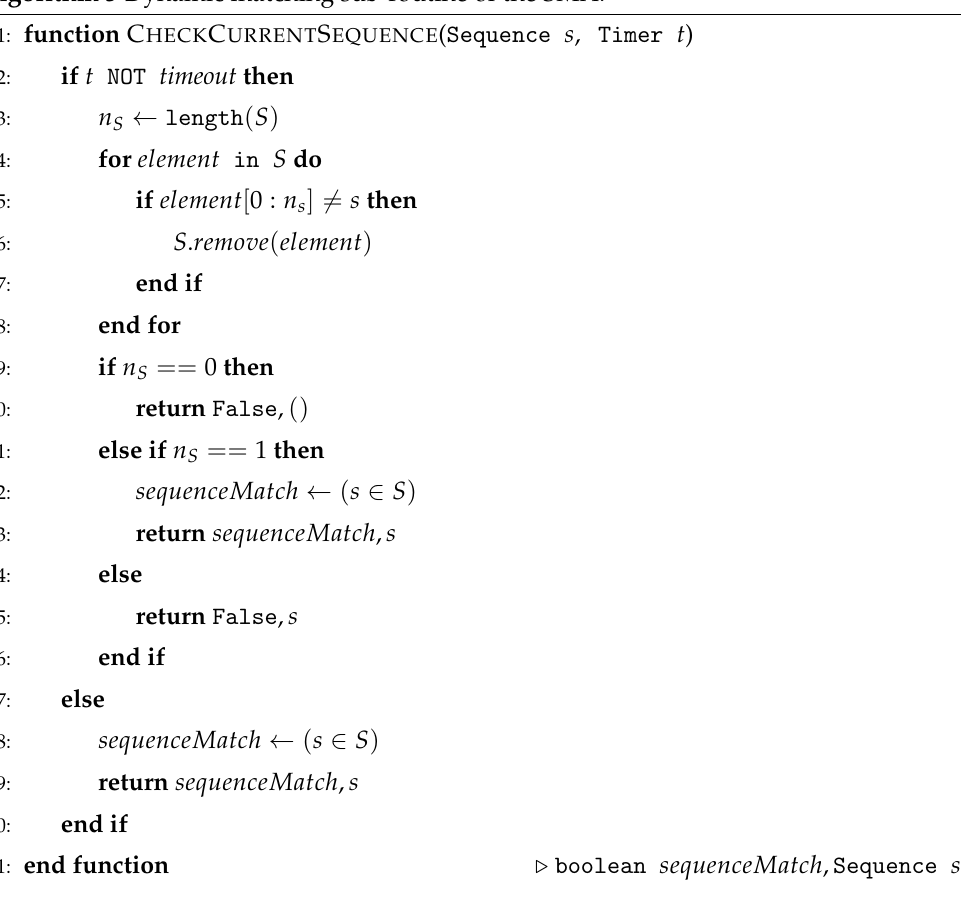
Algorithm 3 Dynamic matching sub-routine of the